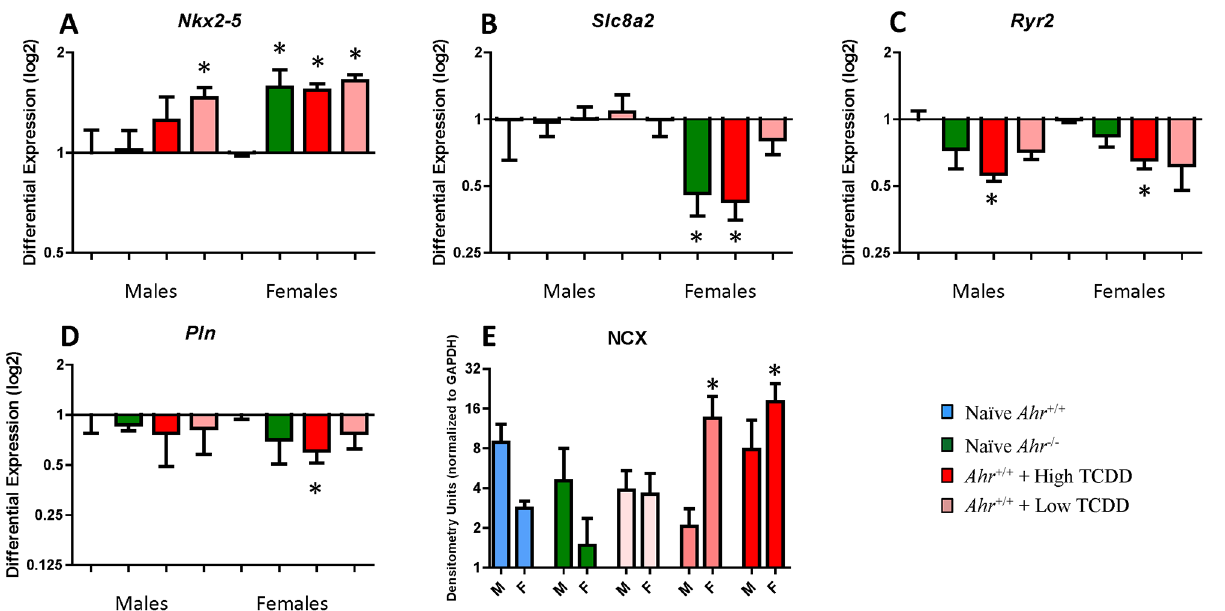
Fig 4. In utero disruption of AHR signaling modestly affects calcium-handling signaling. Fold change mRNA expression of Nkx2-5 (A), Slc8a2 (B), Ryr2 (C), and Pln (D), and protein expression of NCX (E) from na ï ve Ahr +/+ and Ahr -/- and high and low dose TCDD-exposed mice at 10 months of age (PND 300) (mean ±